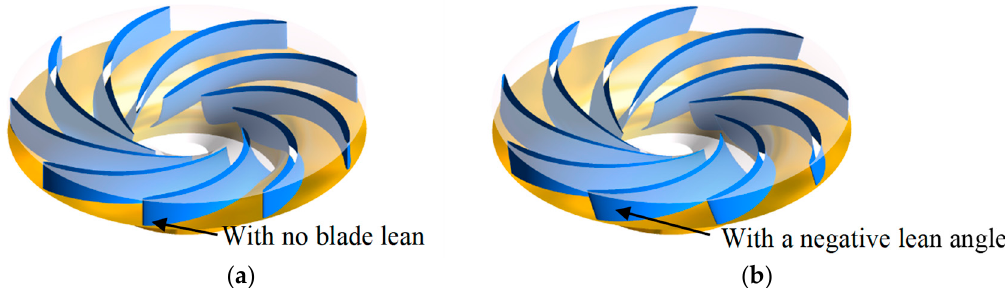
Figure 15. The two runners. ( a ) Original runner; ( b ) improved runner.